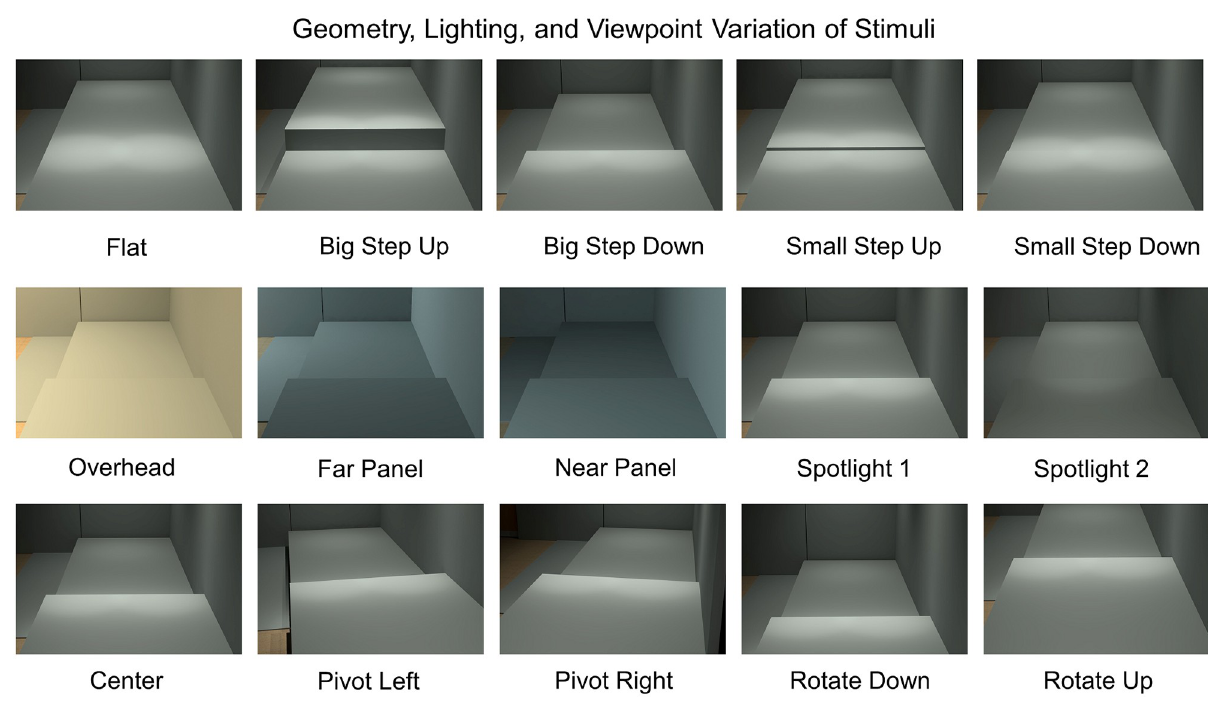
Fig 2. Geometry, lighting, and viewpoint variation of stimuli. The top row used the lighting setting “spotlight 1” and viewpoint setting “center” to demonstrate the five target types: flat, big step-up big step-down, small step-up, and small step-down. The middle row used big step-down and center viewpoint to show the five lighting variations: overhead, far panel, near panel, spotlight 1, and spotlight 2. The bottom row used big step-down and spotlight 1 to show the five viewpoints: center, pivot left, pivot right, rotate down, and rotate up.